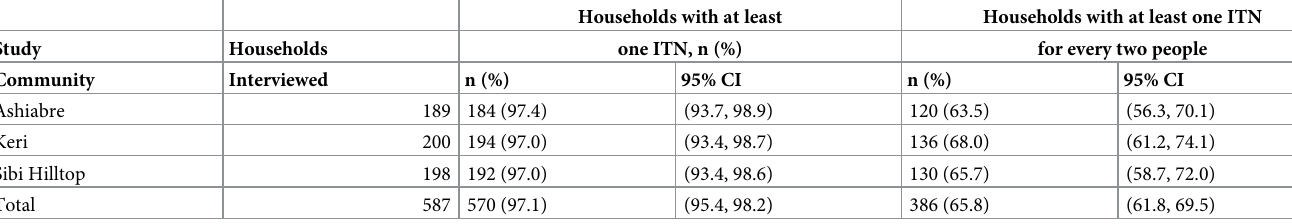
Table 7. Ownership of ITNs by enrolled households in study community. Households with at least Households with at least one